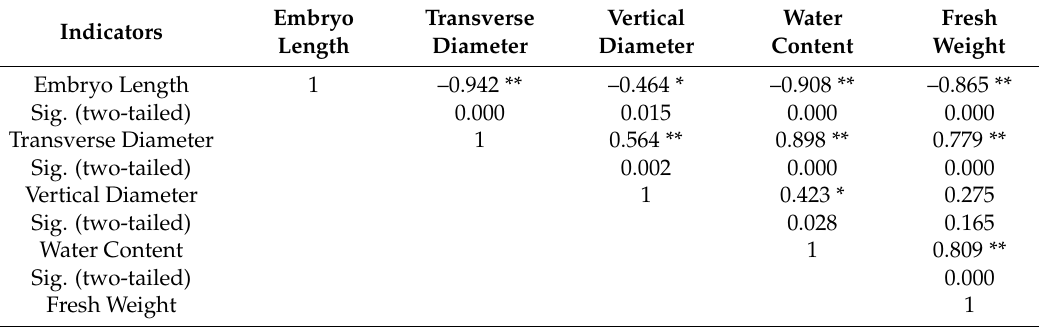
Table 2. Correlation analysis between embryo length, vertical diameter, transverse diameter, water content, and fresh weight during seed development of Ginkgo biloba ‘Jiafozhi’.